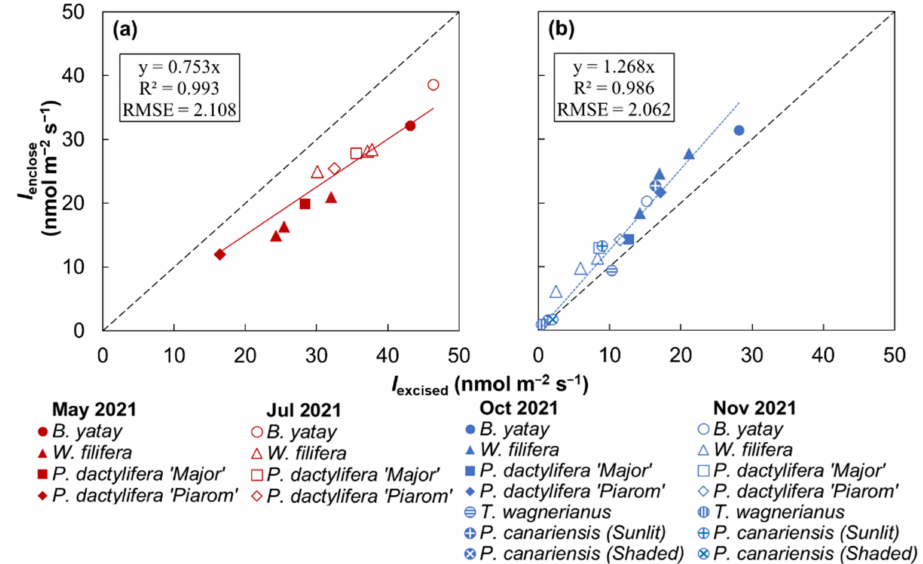
Figure 5. Comparison of isoprene emission rates obtained by the enclosure method ( I enclose ) and the method using excised leaves ( I excised ) for multiple palm species at water temperatures of ( a ) 30 ◦ C and ( b ) 25 ◦ C. Solid lines represent linear regression between I enclose and I excised , where the intercept value was set to zero. (RMSE: root mean square